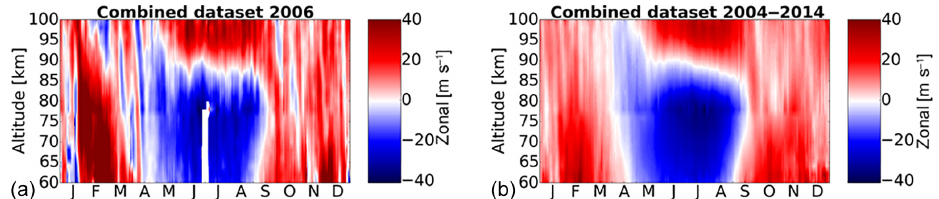
Figure 14. Zonal wind component for the year 2006 (a) and the composite for the years 2004–2014 (b) . Below 78km the data are based on the MF system, and above 92km they are based on the MR radar. The overlapping area is based on the MR and the gaps within this area are filled with weighted MF radar data according to the correction functions in Table 3. The white areas during June 2006 are missing